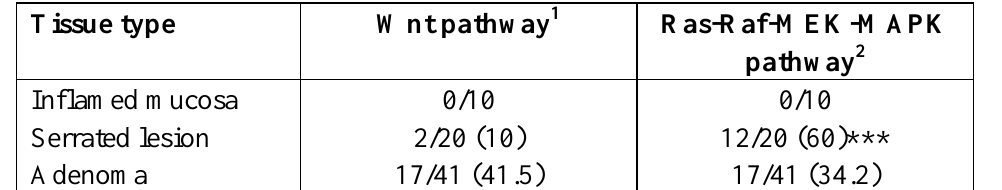
Table 3. Frequency of genetic alterations affecting the Wnt or the Ras-Raf-MEK-MAPK pathway in the colorectal lesions